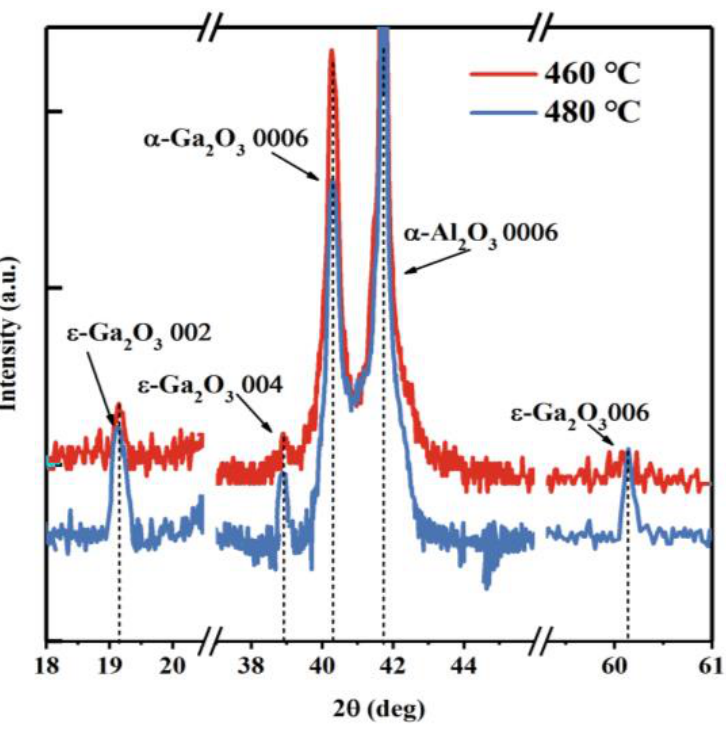
Figure 3. XRD θ -2 θ diffraction profiles of Ga 2 O 3 thin films grown at 460 ◦ C and 480 ◦ Figure 3. XRD θ - 2θ diffraction profiles of Ga 2 O 3 thin films grown at 460 ℃ and 480 ℃ .